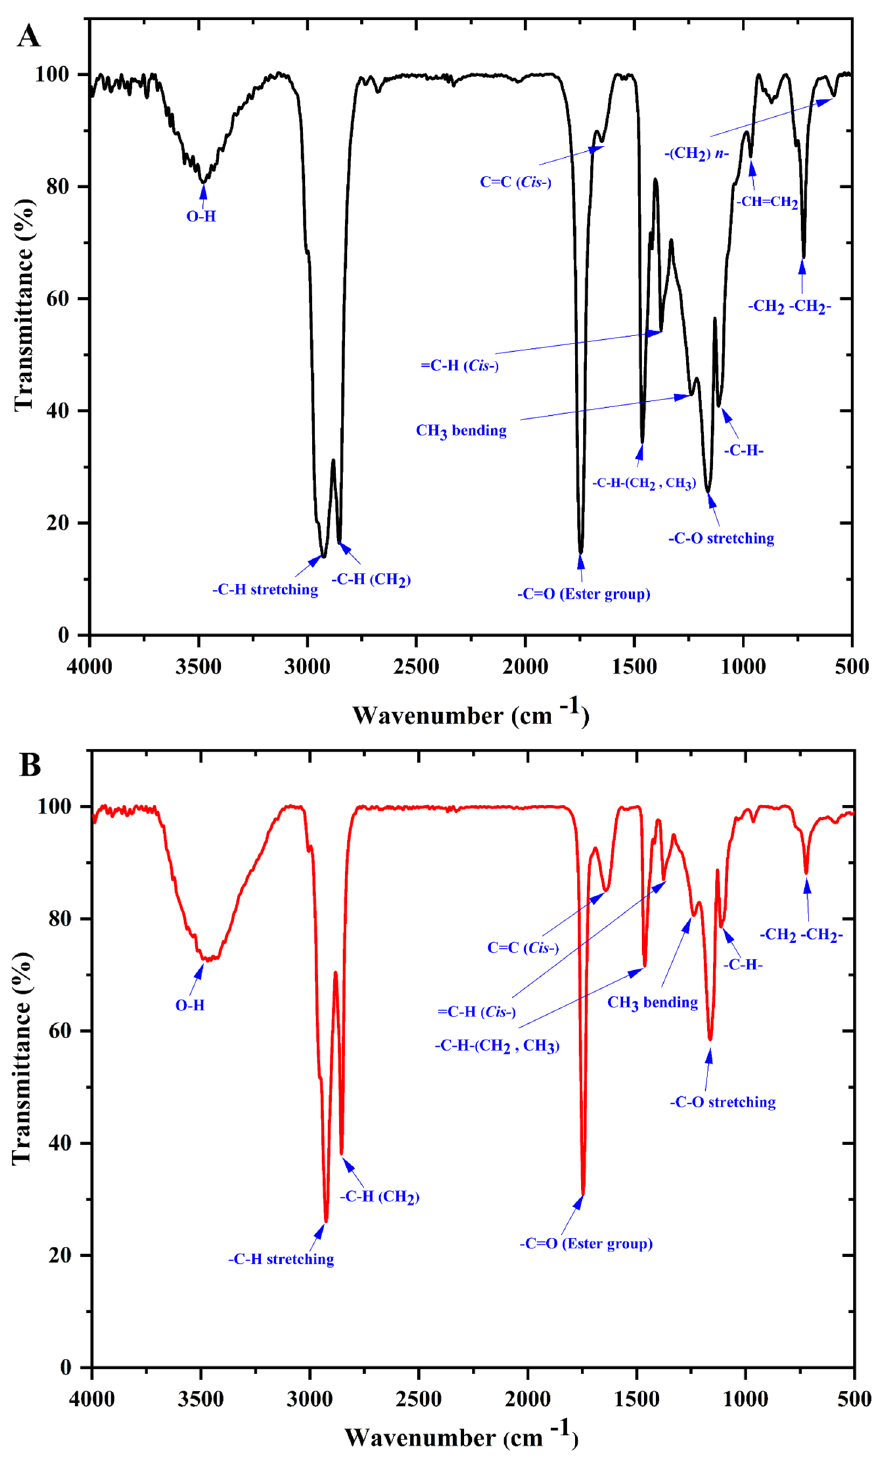
Figure 5. FT-IR spectra of goat milk fat samples fractions in the range of wavenumber 4000–500 cm − 1 ; ( A ) Guanzhong goat milk (GZG); ( B ) Xinong Saanen goat milk (XSG).